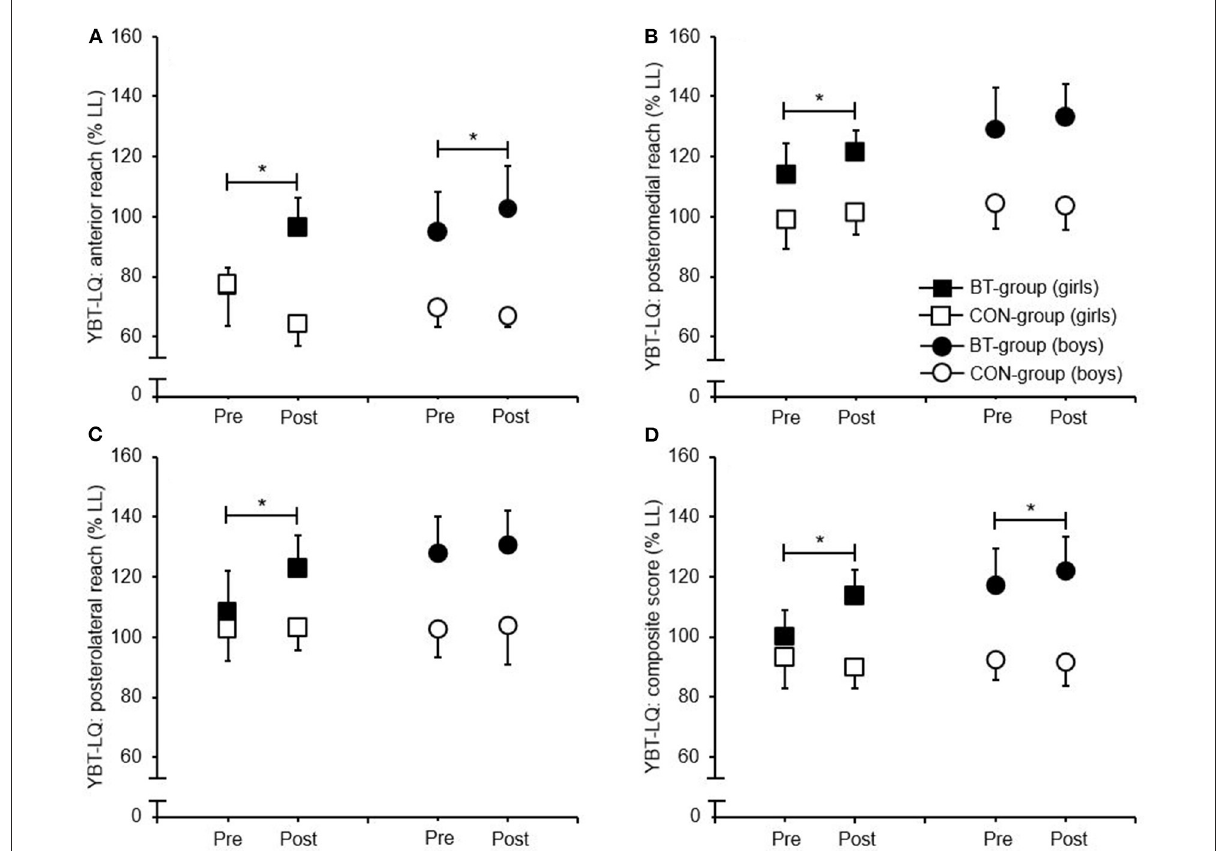
FIGURE1 Group-specific performance changes (mean ± standard deviation) from the pretest to the posttest for the Lower Quarter Y-Balance test [ (A) anterior reach distance; (B) posteromedial reach distance; (C) posterolateral reach distance; (D) composite score]. *Represents a statistically significant performance enhancement from the pretest to the posttest in favor of the BT-group ( p < 0.05). BT, balance training group; CON, active control group (i.e., received regular physical education lessons); LL, leg length; YBT-LQ, lower quarter Y-balance